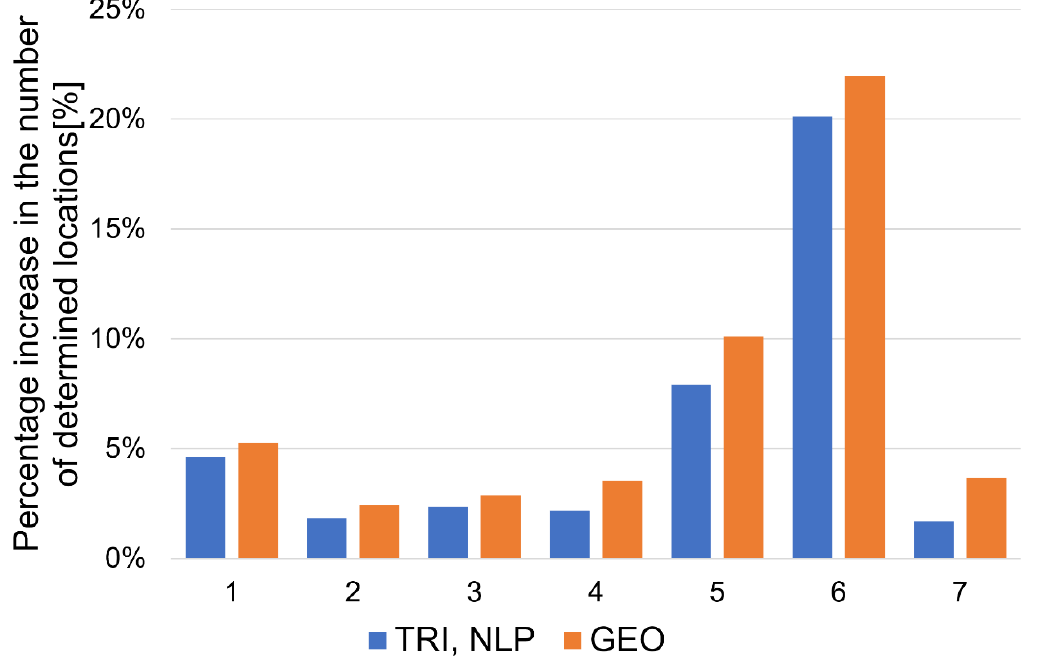
Figure 23. Results of the average quality indicators Q for localization algorithms (final filtering).